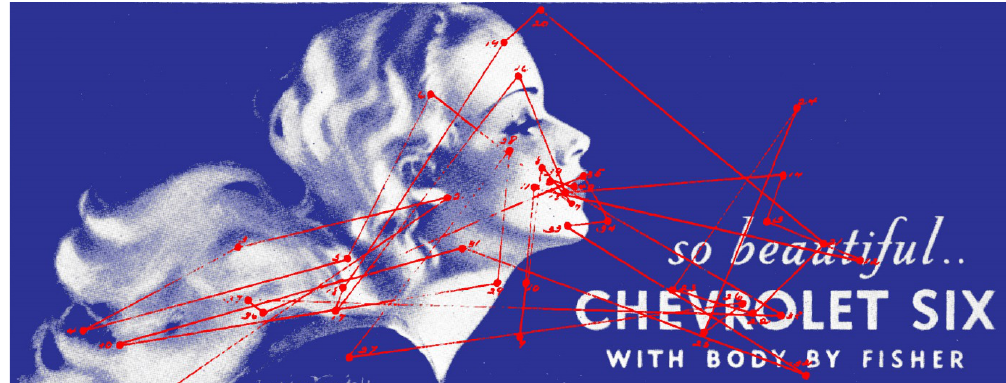
Figure 15. Poster girl . The sequence of saccades and the locations of fixations in observer 27 when viewing an advertising post- er. (Adapted from Picture 48 and Plate LXVII in Buswell,